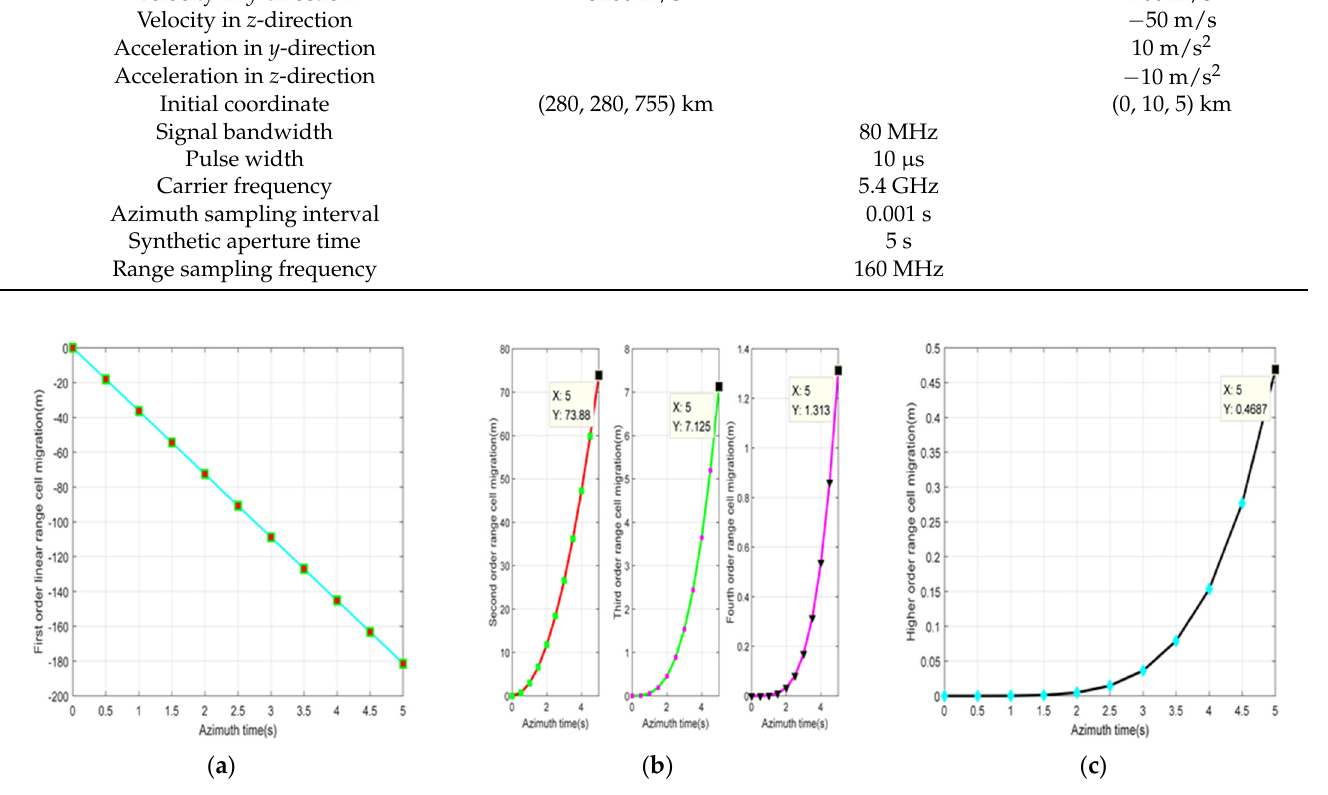
Figure 2. Each order term of the range cell migration. ( a ) The first-order term; ( b ) from the second- order to the fourth-order term; ( c ) the high-order term. Table 1. Simulation experimental parameters of spaceborne missile bistatic SAR.